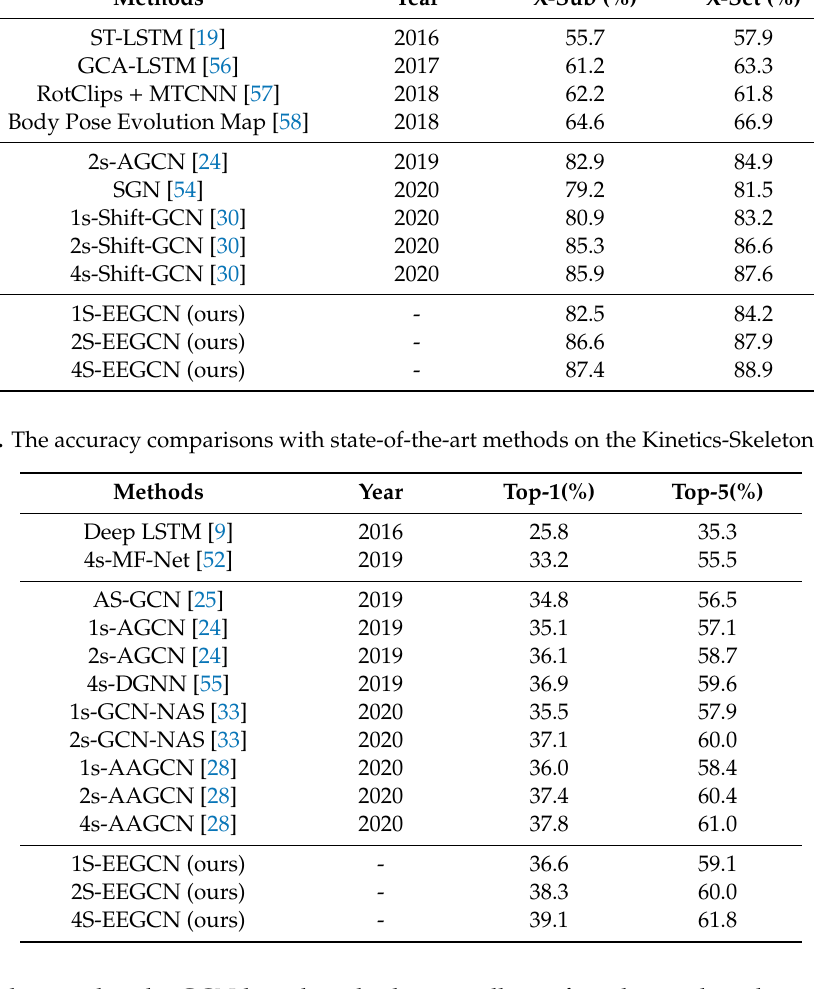
Table 7. The accuracy comparisons with state-of-the-art methods on the NUT-GRB + D 120 dataset. Methods